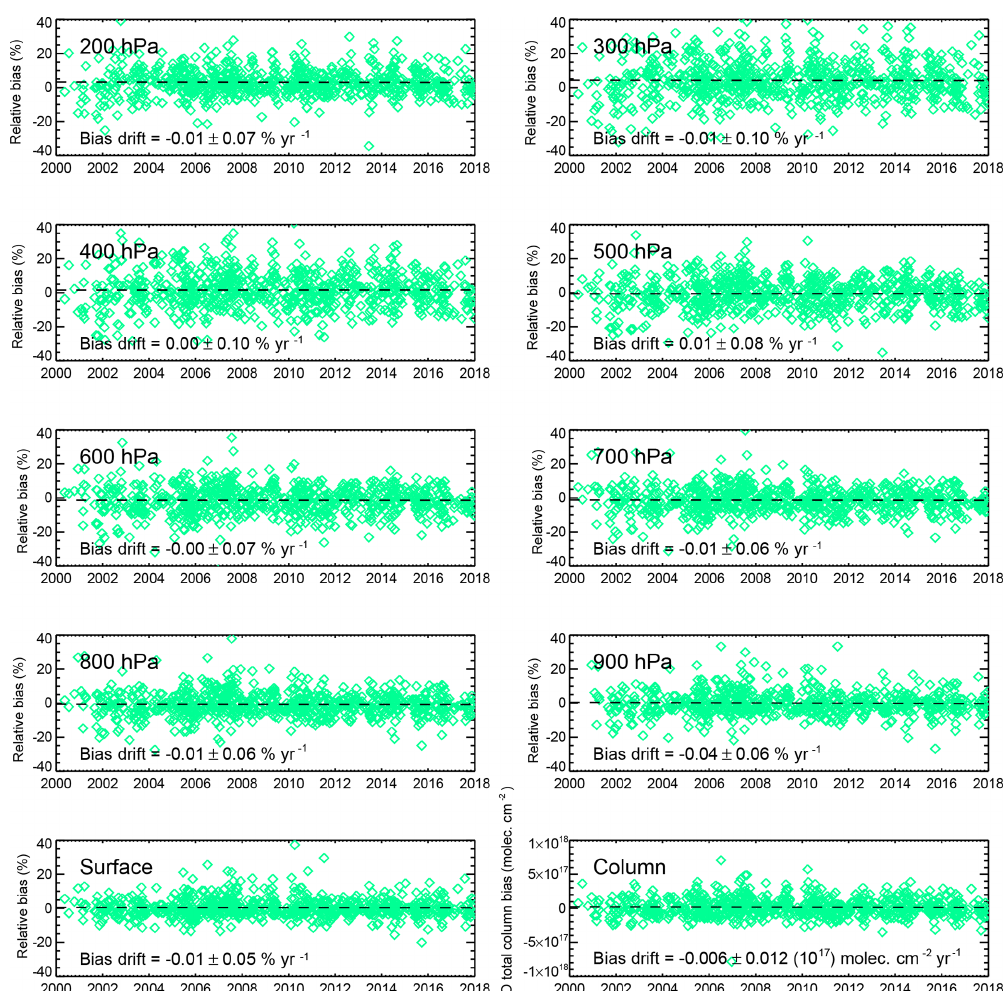
Figure 5. Retrieval bias drift for V8 TIR-only products based on the NOAA flask